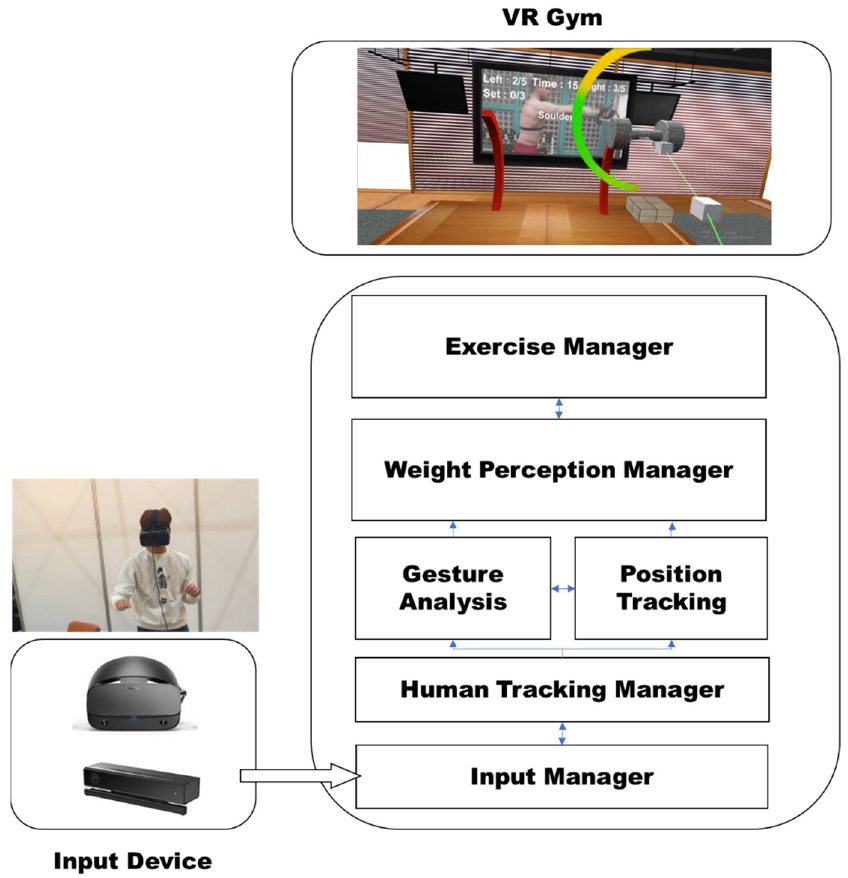
Figure 2. System Figure 2. System architecture.